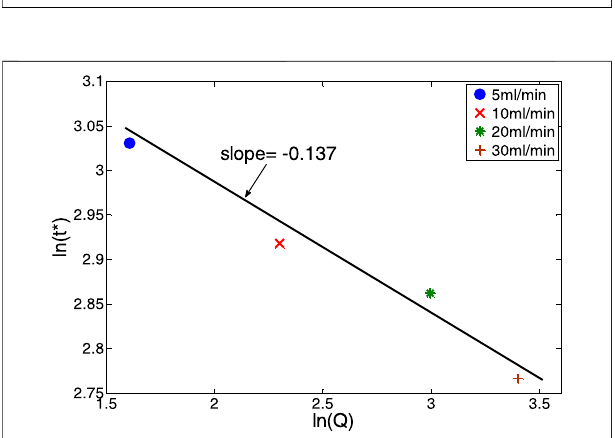
FIGURE 6 | Temporal evolution of the bubbles plume fronts under various gas release rates.